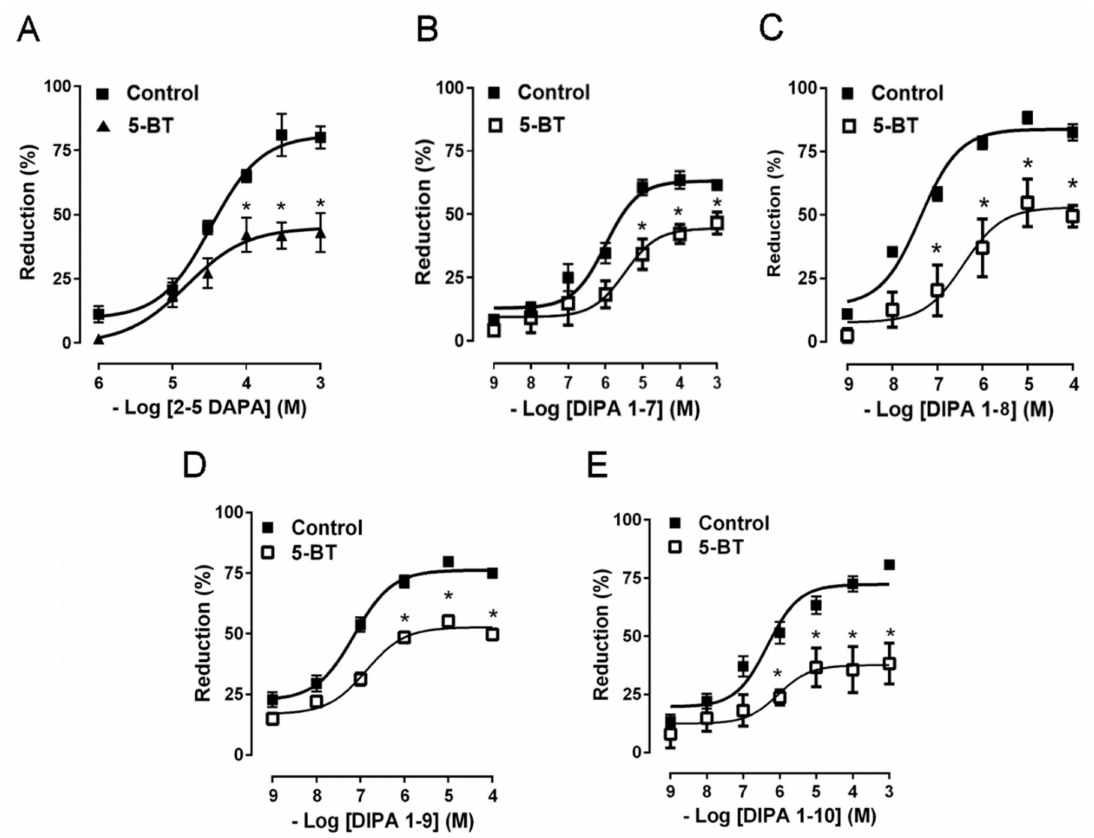
Figure 3. Concentration–response curves showing the inhibitory e ff ects of increasing concentrations of DAPA 2–5 (1 µ M–1 mM) ( A ), DIPA 1–7 (1 nM–1 mM) ( B ), DIPA 1–8 (1 nM–100 µ M) ( C ), DIPA 1–9 (1 nM–100 µ M) ( D ), and DIPA 1–10 (1 nM–1 mM) ( E ) on the spontaneous contractions of human colon circular muscle, in the presence or in the absence of 5-BT (1 µ M). Data are means S.E.M. ( n = 6 for each experimental conditions) and are expressed as percentage of inhibition of the spontaneous contractions. * p < 0.05 compared with the respective control conditions.